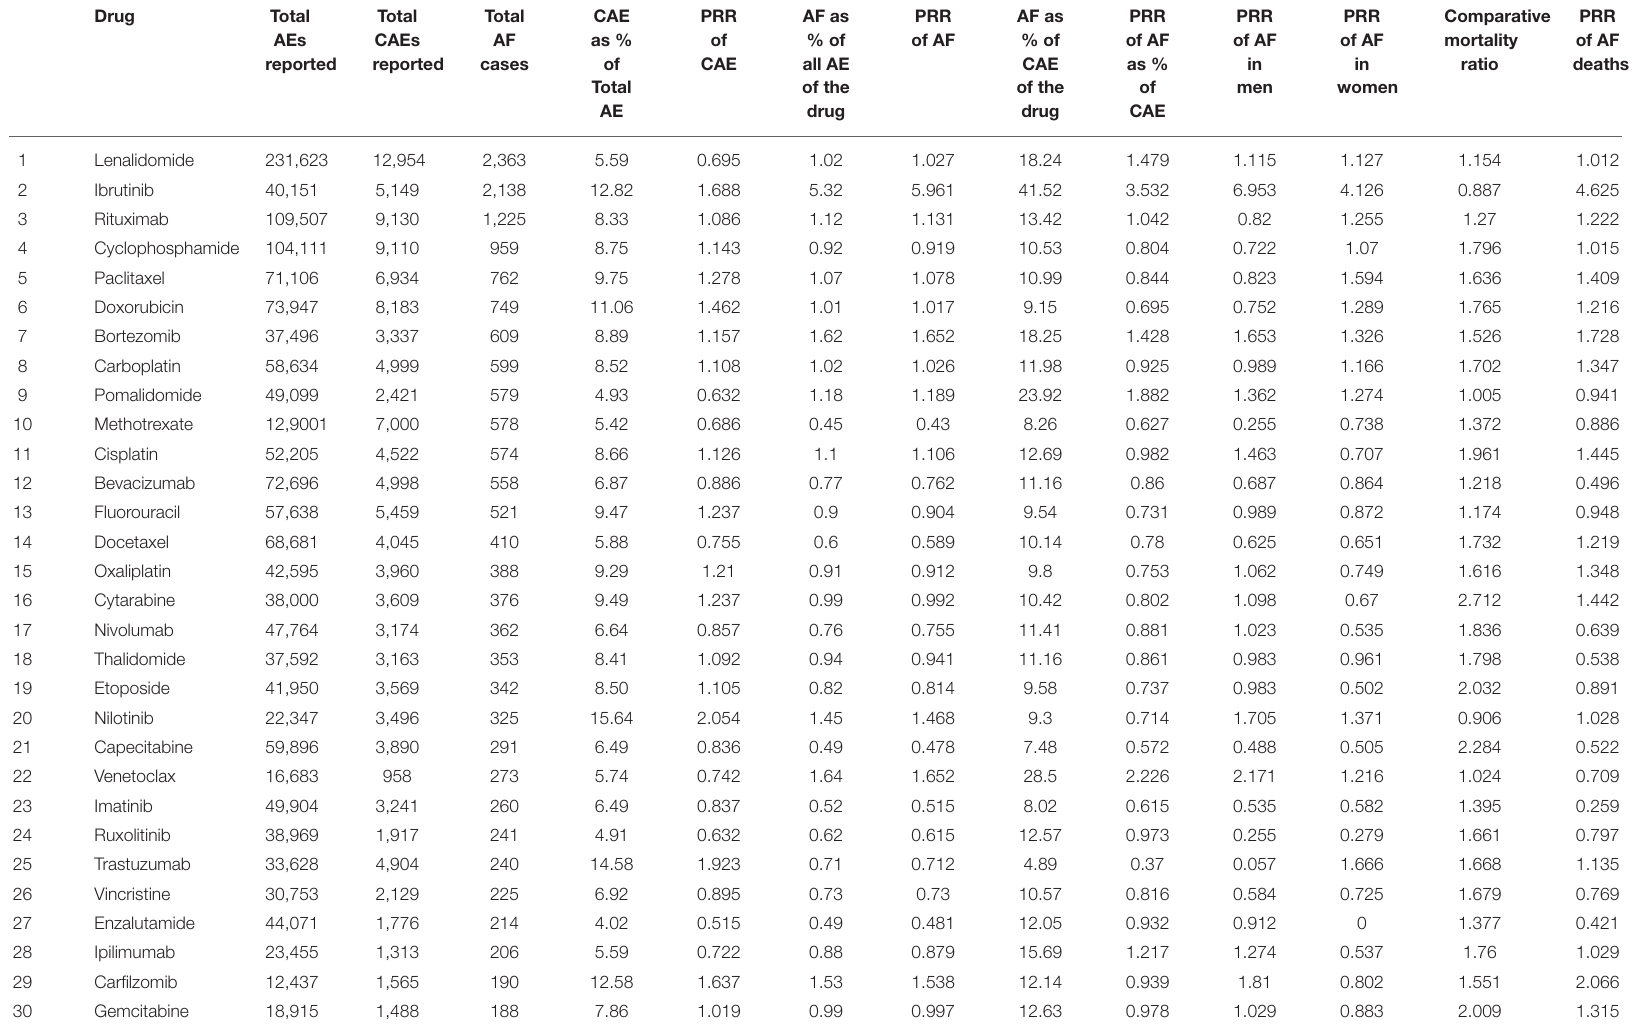
TABLE 1 | The proportion of cases of AF, CAE, deaths, and PRR for all variables for all 30 drugs included in the